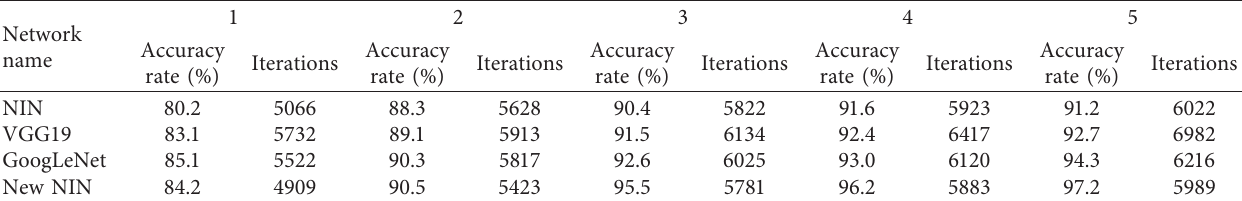
Table 2: Comparison of experimental results on the Stanford Cars